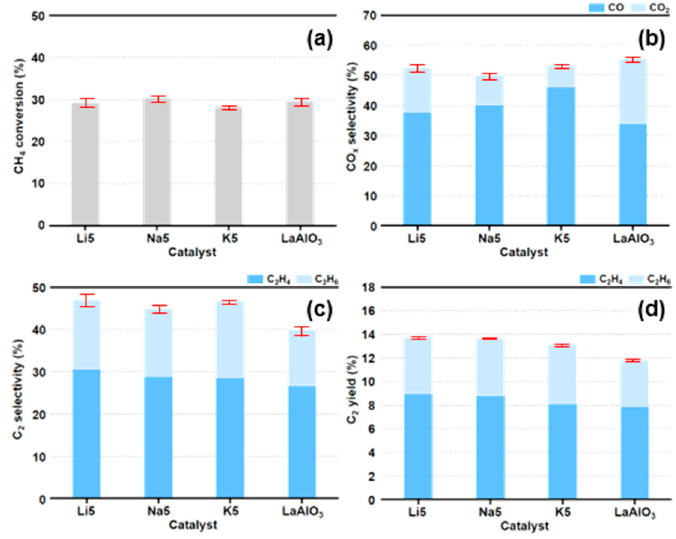
Figure 3. Catalytic activities in terms of LaAlO 3 _X5 and LaAlO 3 catalysts in the OCM: ( a ) CH 4 con- version (%), ( b ) CO x selectivity (%), ( c ) C 2 selectivity (%), and ( d ) C 2 yield